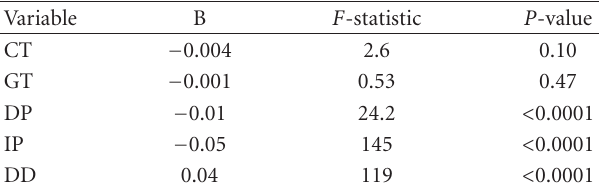
Table 4: Influence of age on subtest scores (Fisher